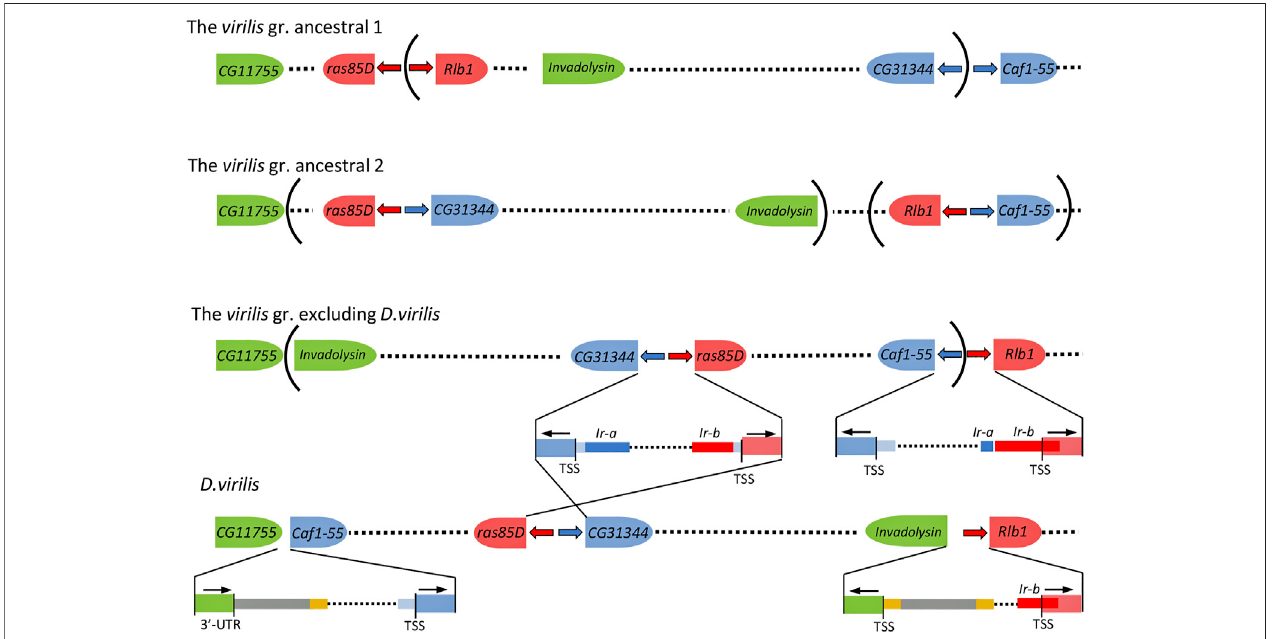
FIGURE 4 | The minimal number of rearrangements required to transform the ancestral state of chromosome 2 to speci fi c for the virilis group. Blue and red arrows — the inverted repeats Ir-a and Ir-b, respectively, that marked insertion sites of two copies of the Uncharacterized X DNA Transposon into the ras85D — Rlb1 and CG31344 — Caf1-55 intergenic regions in the ancestor of the virilis species group. DAIBAM elements are colored with yellow (inverted terminal sequences) and gray (Reis, et al., 2018). Remnants of ancestral sequences are colored with light blue. The nomenclature of the genes corresponds to the names of D. melanogaster orthologs. The representation is not to